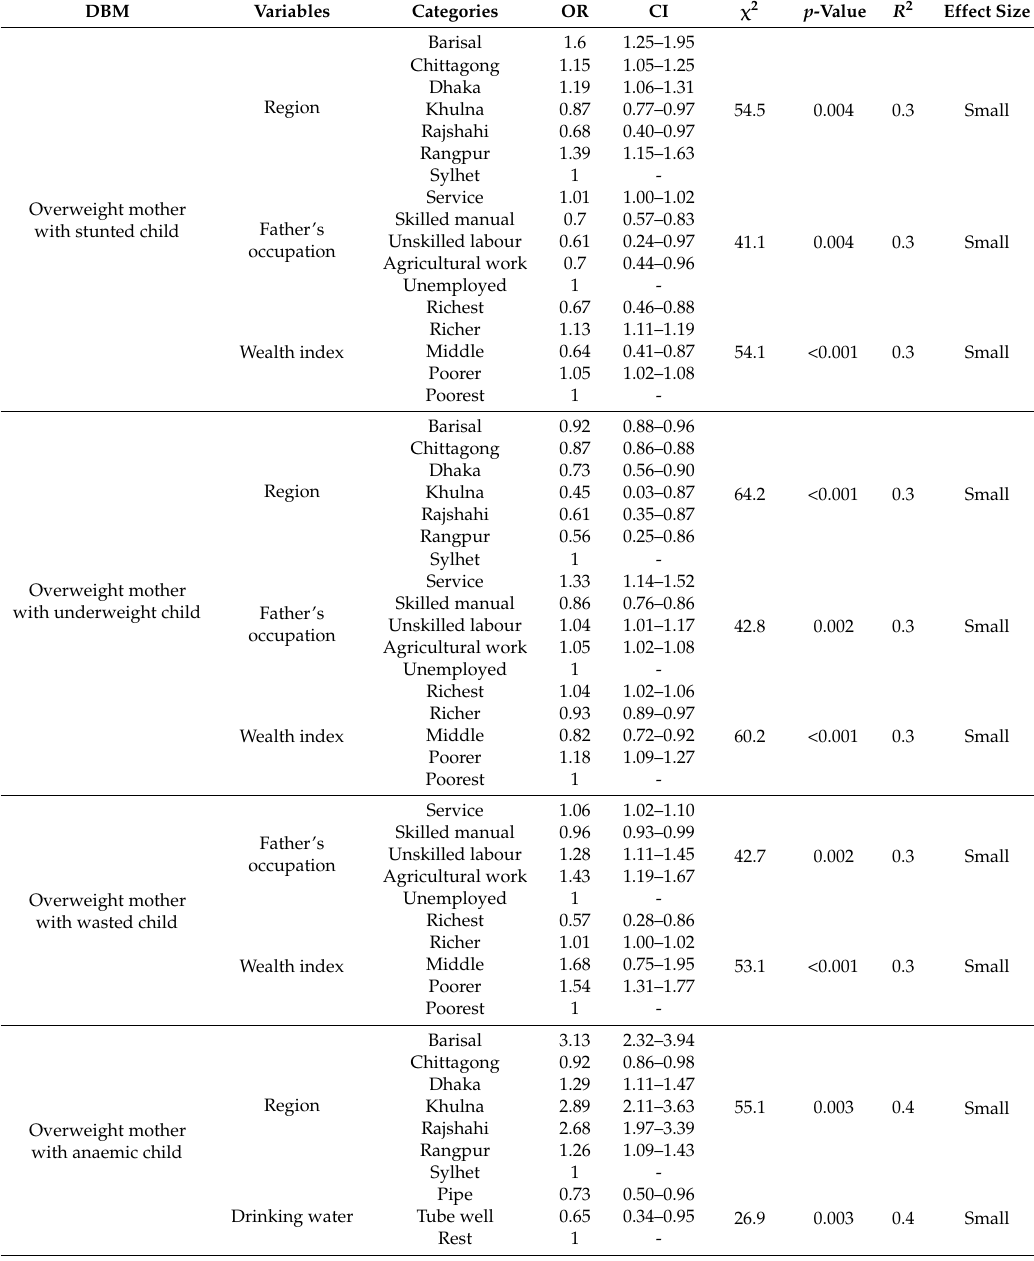
Table A1. Sequential multinomial logistic regression analysis of DBM in mother–child pairs by socio-demographic variables for the Asian cut-off point (maternal